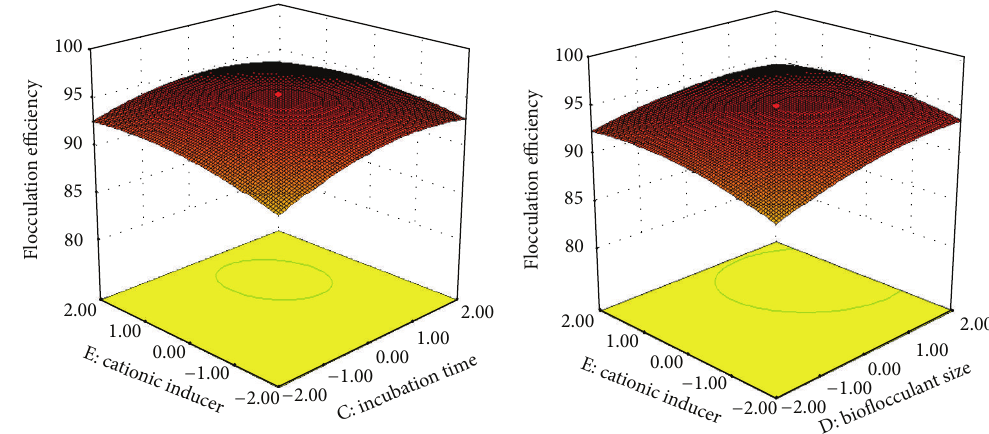
Figure 2: 3D Response surface and contour plots representing various interactive effects of variables on